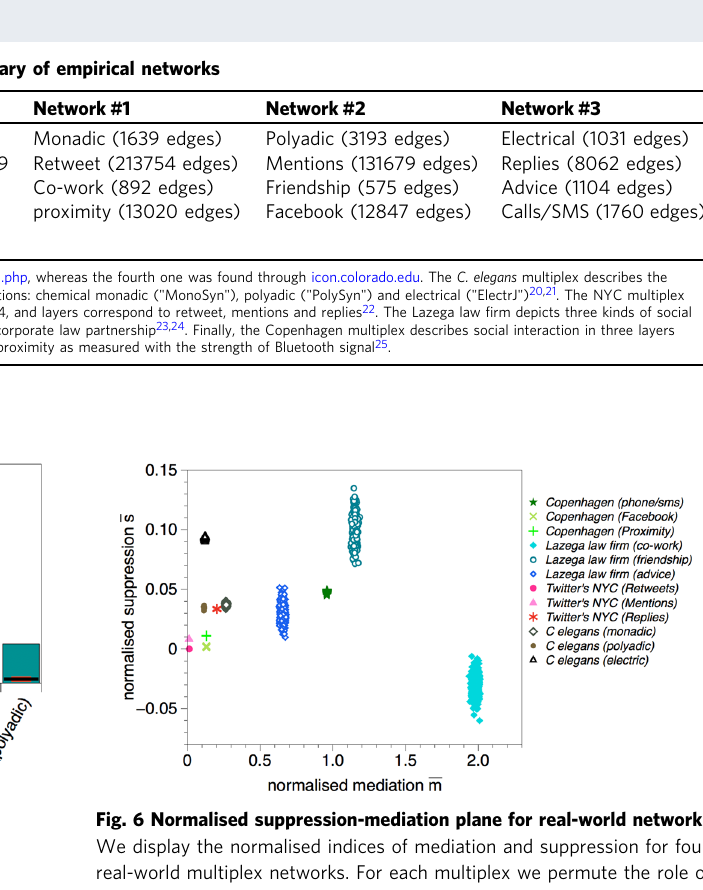
Table 1 Summary of network speci fi cities.